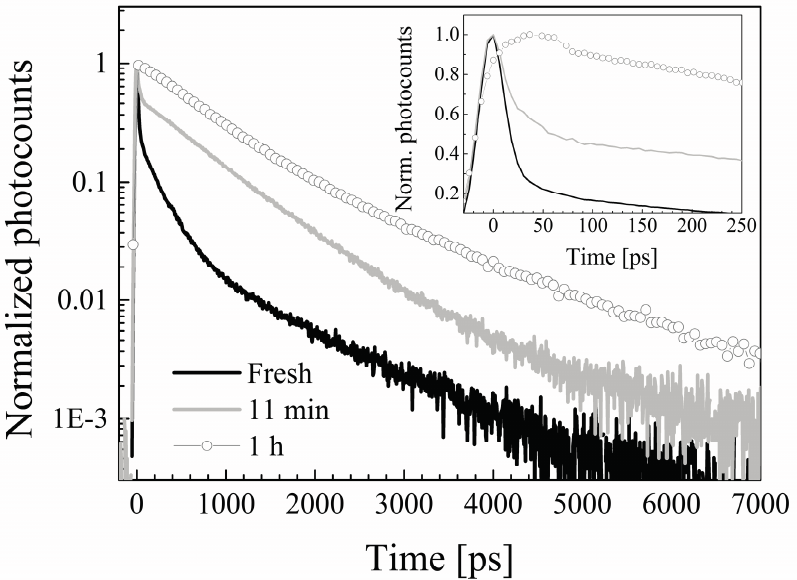
Figure 7. Fluorescence decay patterns of a freshly prepared CYV solution in chloroform (black line), and of the same solution after 10 min (gray line) and one hour (dots) of exposure to the laser